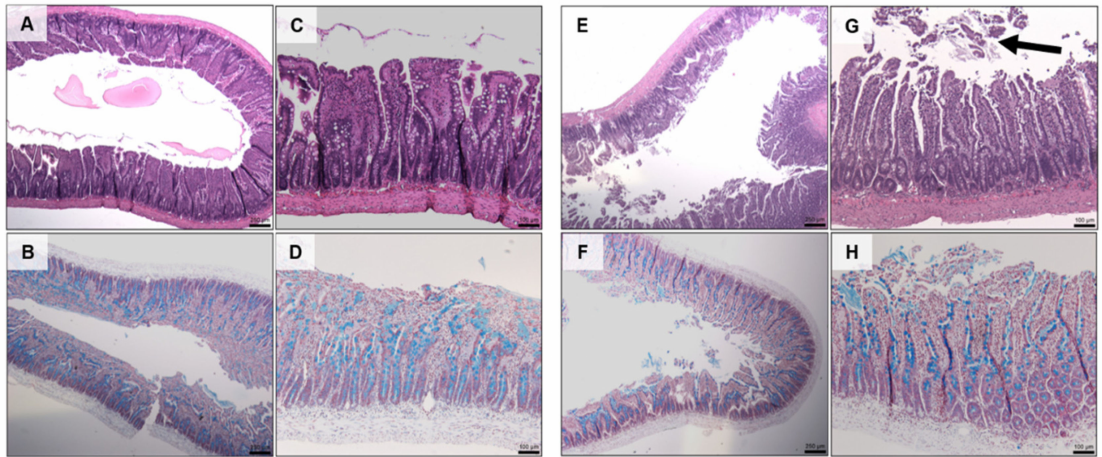
Figure 9. H & E (top) and AB & NR (bottom) staining of jejunal tissue following 2 h in vivo exposure to dWPI-insulin beads with and without C 10 . ( A – D ) prototype, ( E – H ) prototype + C 10 . Scale bars = 250 µ m ( A , B , E , F ), and 100 µ m ( C , D , G , H ). Arrow in G shows cell